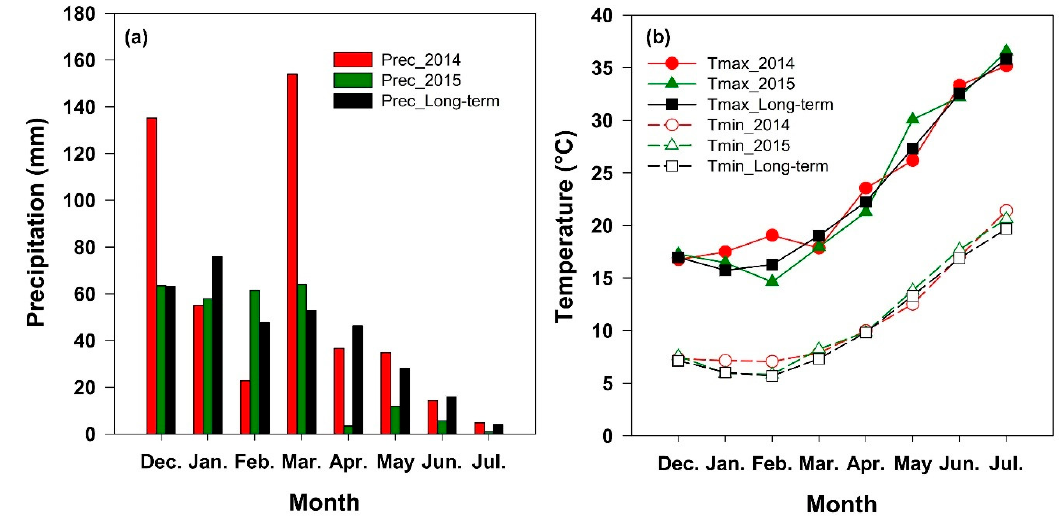
Figure 1. ( a ) Monthly precipitation (Prec), ( b ) minimum air temperature (Tmin), maximum